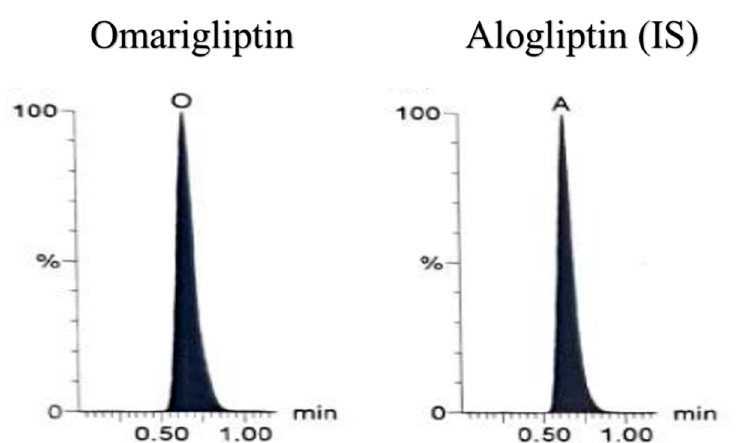
Figure 8. Multiple reaction monitoring (MRM) chromatogram of omarigliptin ( m / z = 399.2 to 153.0) and